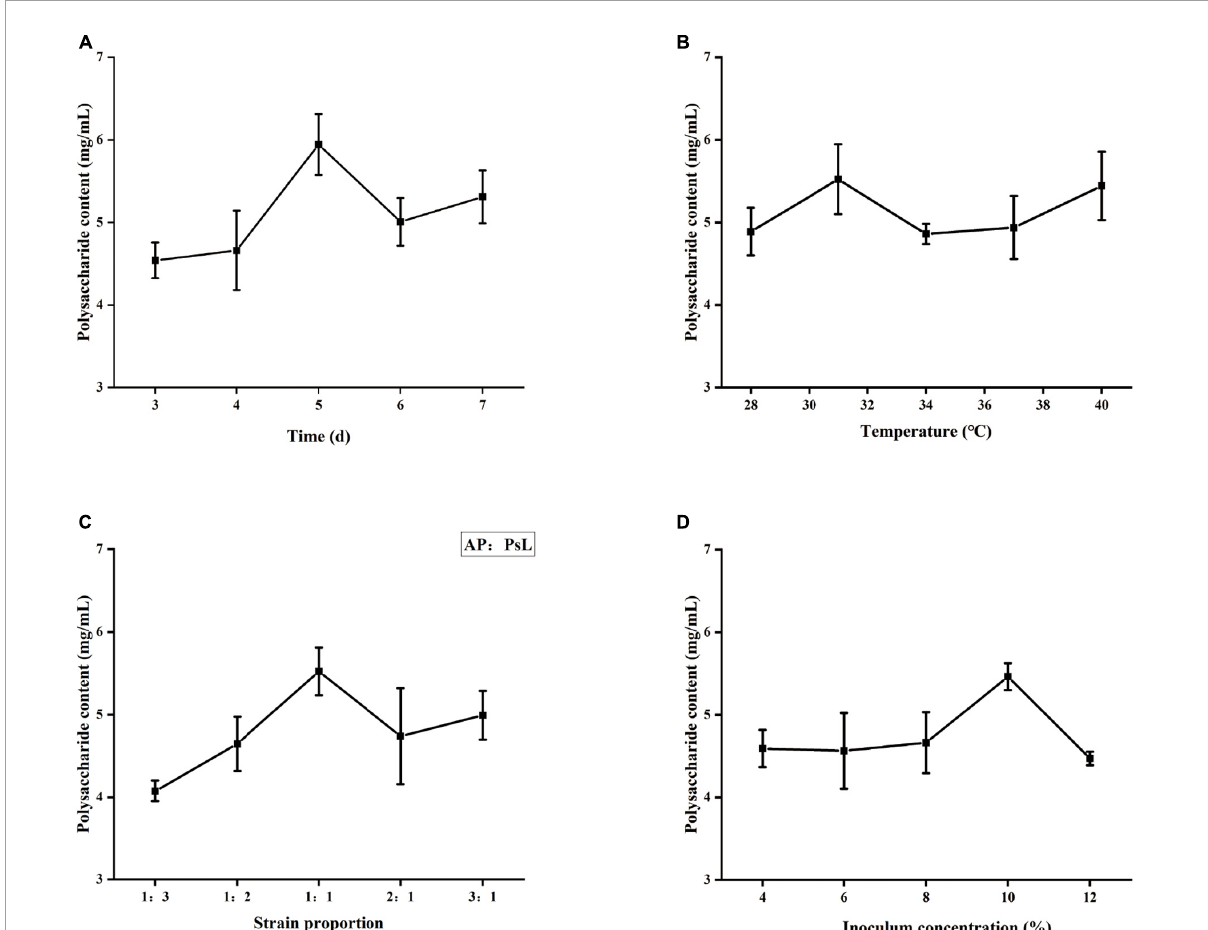
FIGURE6 Effects of different factors on polysaccharide yield. (A) Fermentation time, (B) fermentation temperature, (C) strain proportion, and (D) inoculum